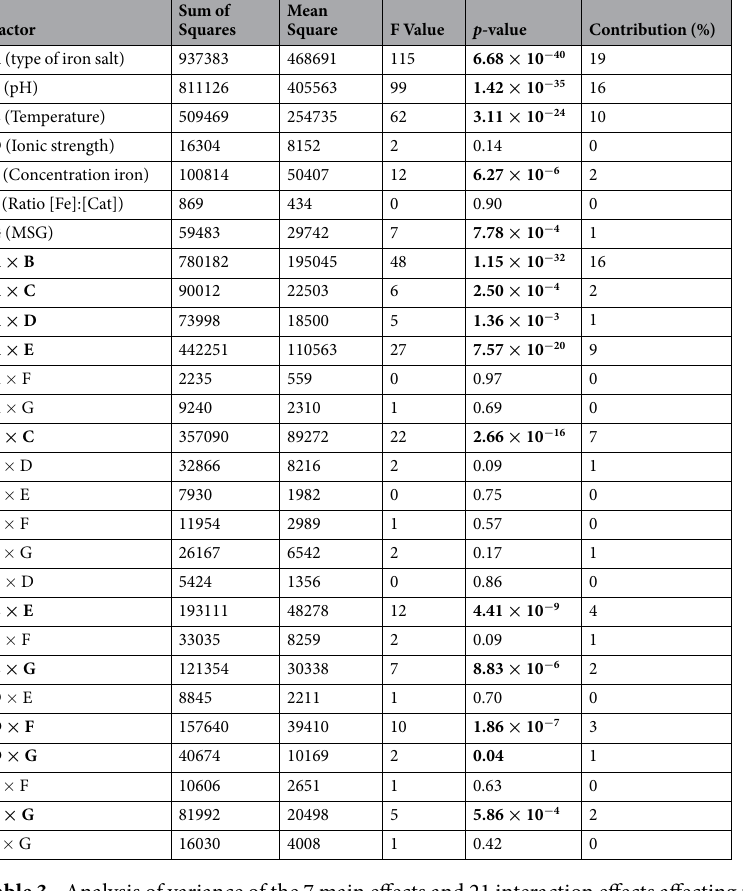
Table 3. Analysis of variance of the 7 main effects and 21 interaction effects affecting iron-catechol complexation, significant factors and corresponding p- values are indicated in bold (R 2 = 0.76 and R 2 adj =